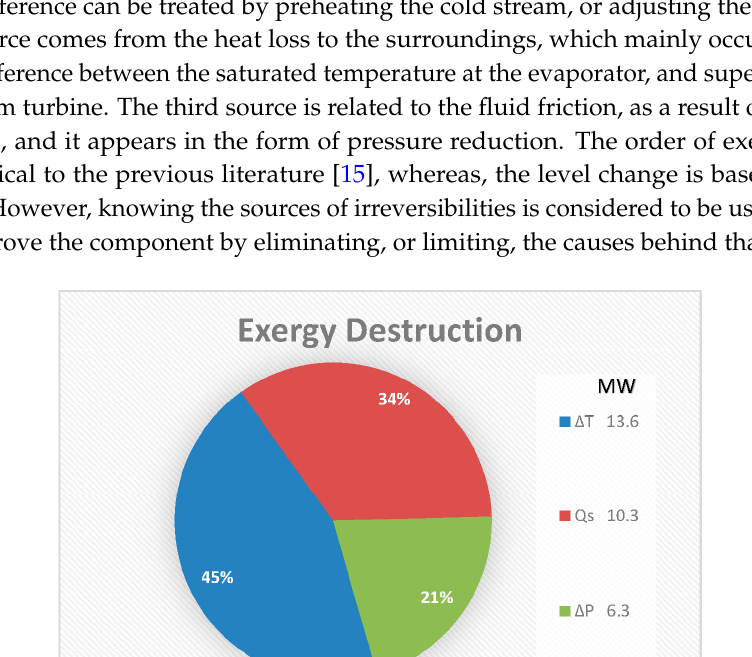
Figure 8. Exergy destruction for all HRSG stages at ISO condition.